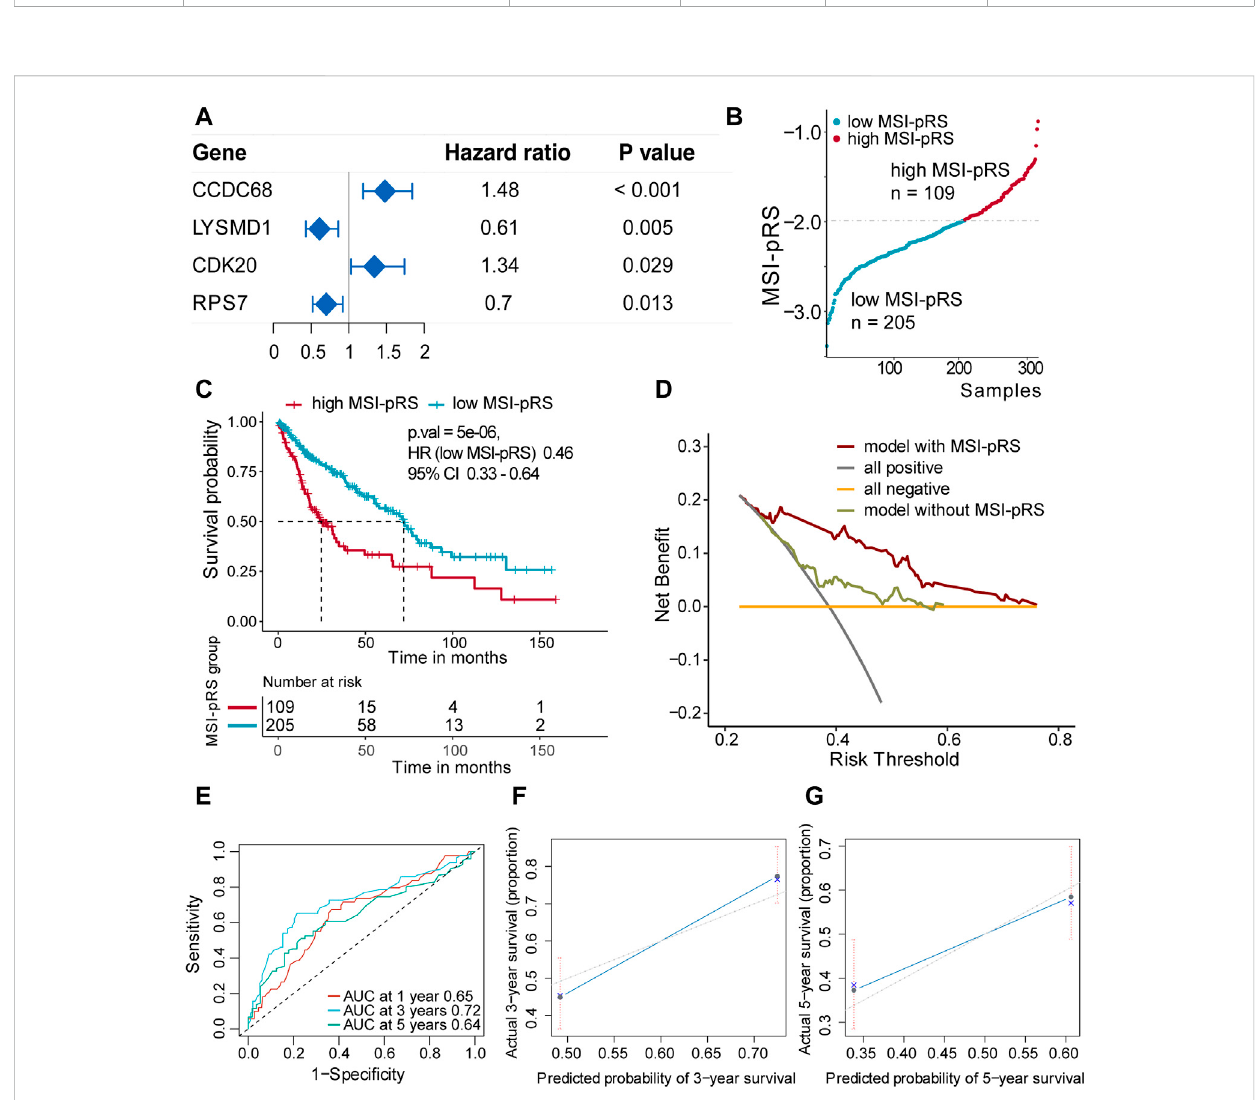
FIGURE 6 ConstructionofMSI-related prognostic riskscore (MSI-pRS) intheTCGAtraining cohort. (A) Forest plotofprognosticgenes usedto construct MSI- PRS.Hazardratio(HR)ofeachgenewasderivedfromtheunivariateCoxregressionofthefourgenes. (B) TCGALUSCtrainingcohortwasdividedintotwo groups according to the MSI-pRS. (C) Kaplan-Meier curves of the high MSI-pRS and low MSI-pRS groups in TCGA LUSC training cohort. The overall survival (OS) was used as the primary point. (D) Decision curves of the multivariate Cox model with or without MSI-pRS. The model with